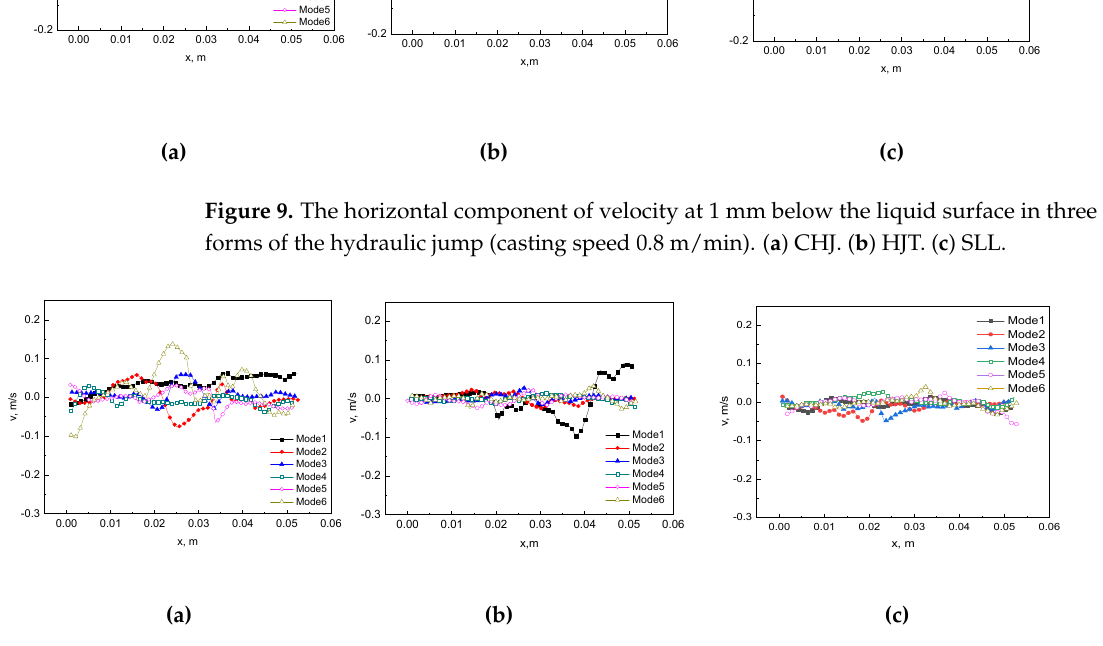
Figure 10. The vertical component of velocity at 1 mm below the liquid surface in three physical forms of the hydraulic jump (casting speed 0.8 m/min). ( a ) CHJ. ( b ) HJT. ( c ) SLL.